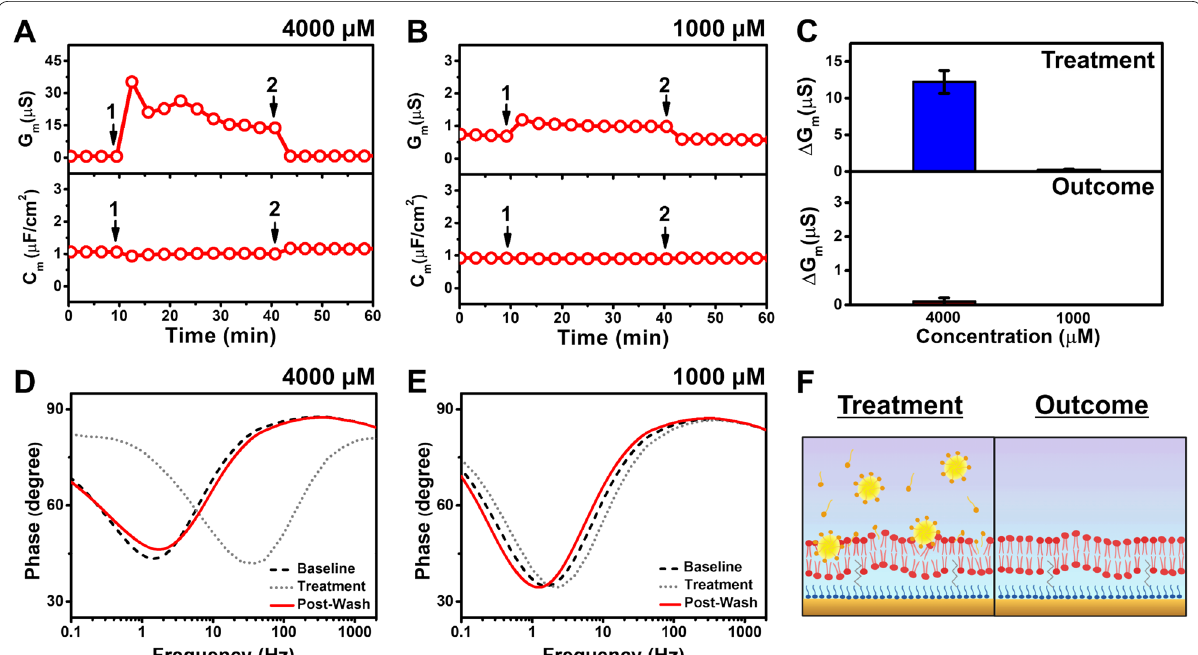
Fig. 5 EIS investigation of undecanoic acid addition to the tBLM platform. Time‑resolve changes in conductance (G m ) and capacitance (C m ) signals following the addition of ( A ) 4000 µM and ( B ) 1000 µM undecanoic acid to the tBLM platform. The initial baseline measurements correspond to the fabricated tBLM platform in PBS solution on the gold electrode. After 10 min of establishing the baseline signals, undecanoic acid was added (arrow 1) and incubated for 30 min before buffer washing was performed (arrow 2). ( C ) Summary of G m shifts upon compound addition (top panel) and after buffer washing (bottom panel) relative to the tBLM baselines. Bode plots describing the phase shifts of the system from baseline signals in response to treatment with ( D ) 4000 µM or ( E ) 1000 µM undecanoic acid and buffer washing. ( F ) Schematic illustration based on the EIS data of how 4000 µM undecanoic acid interacts with the tBLM and the resulting tBLM after undecanoic acid was removed by buffer